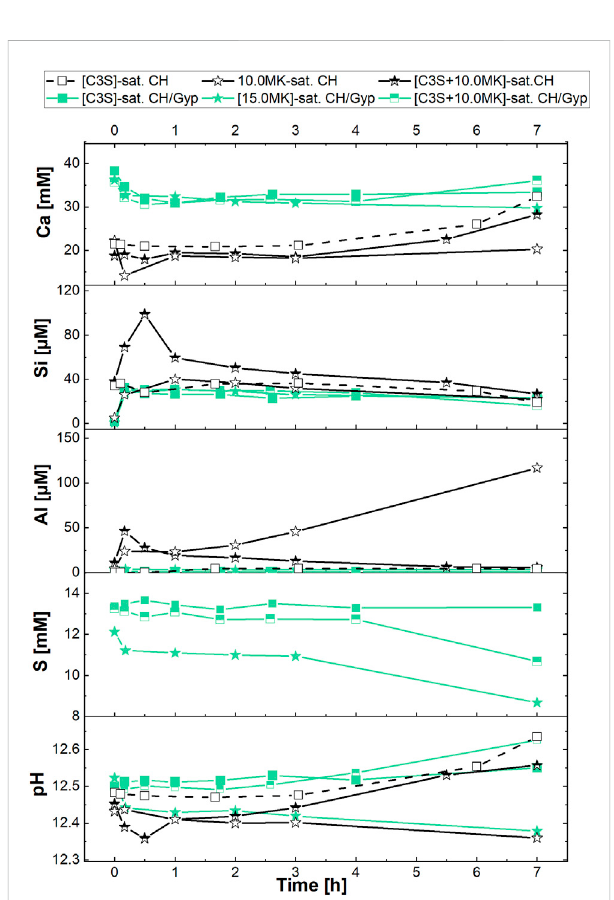
Calcium,silicate,aluminate, sulfateconcentrationsandpHofthe aqueous phase during reaction of C 3 S, MK and [C 3 S + MK] in fi ltered solutions saturated with respect to portlandite as well as portlandite + gypsum in the fi rst 7 h of hydration. The l/C 3 S ratio was 50, the numbers in the legend refer to the MK-dosage in